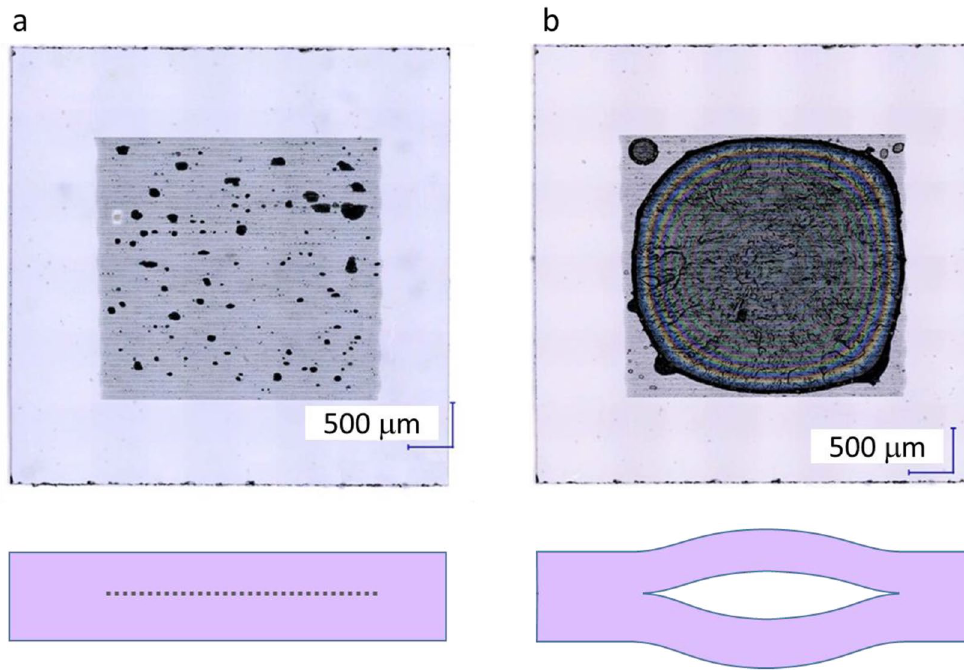
Figure 3. Photographs and cross-sectional schematic images of GaN substrates containing nitrogen bubbles. ( a ) After laser irradiation before heating. ( b ) After